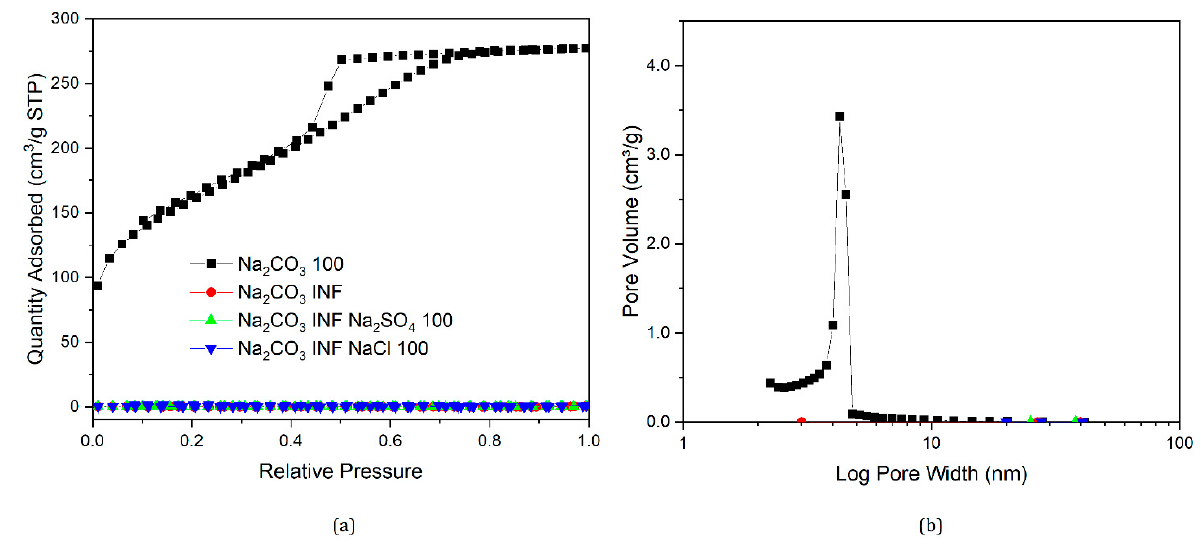
Figure 9. Nitrogen sorption isotherms of gels with modified catalyst composition ( a ) and corresponding pore size distri- butions ( b ).